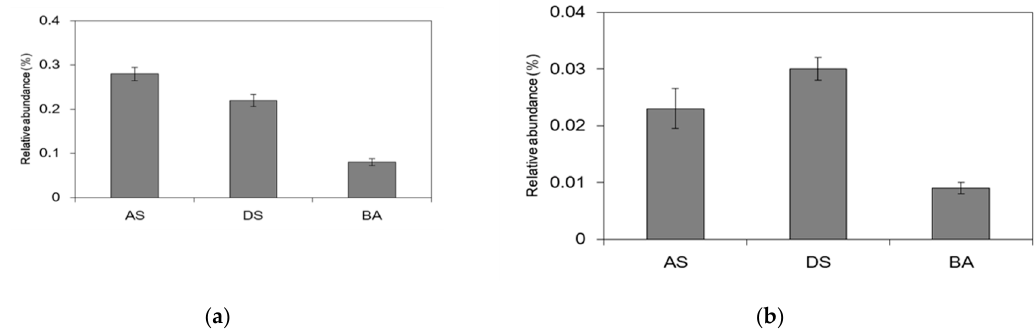
Figure 4. Distribution of mobile genetic elements, including plasmids ( a ) and integrons ( b ), across the three different samples (AS (activated sludge), DS (dewatered sludge), and BA (bioaerosols)). Relative abundances of plasmid- and integron-like reads per total metagenomic sequencing read. The error bars represent one standard deviation.